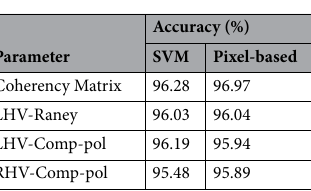
Table 7. Accuracy comparison for DATA2